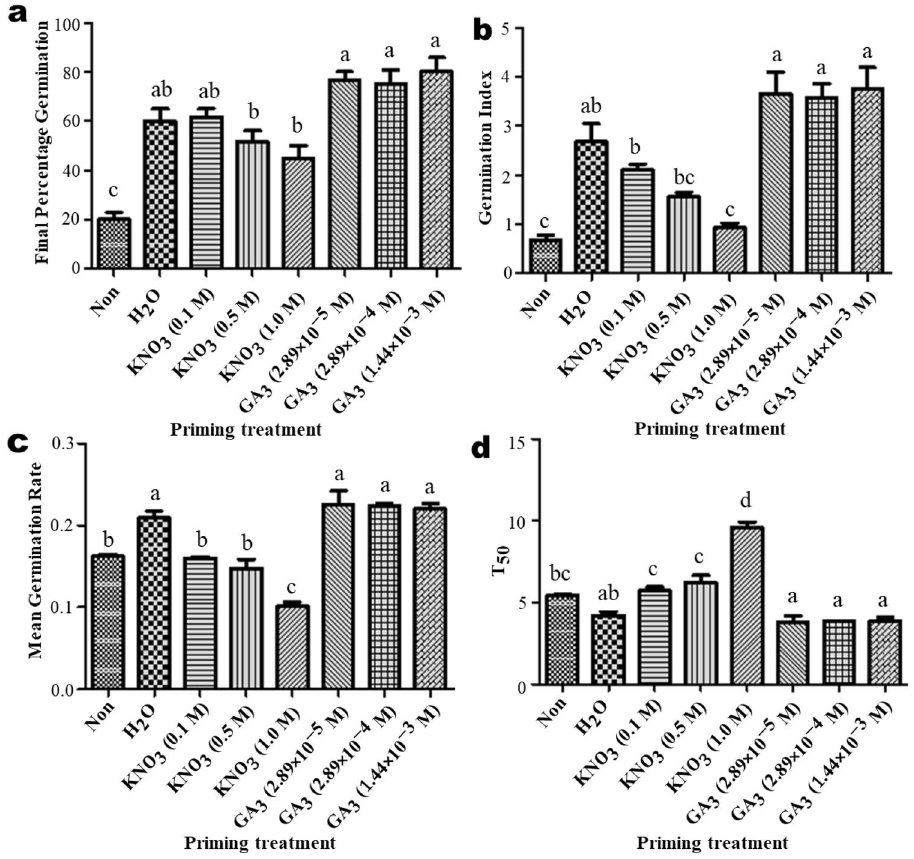
Figure 3. Effect of priming treatment on ex vitro seed emergence parameters of A. africana . ( a ) Final Percentage Germination ( b ) Germination Index ( c ) Mean Germination Rate and ( d ) time required for 50% germination (T 50 ). Values are presented as means ± standard error. Same letters are not significantly different by Tukey’s multiple comparison test and p =